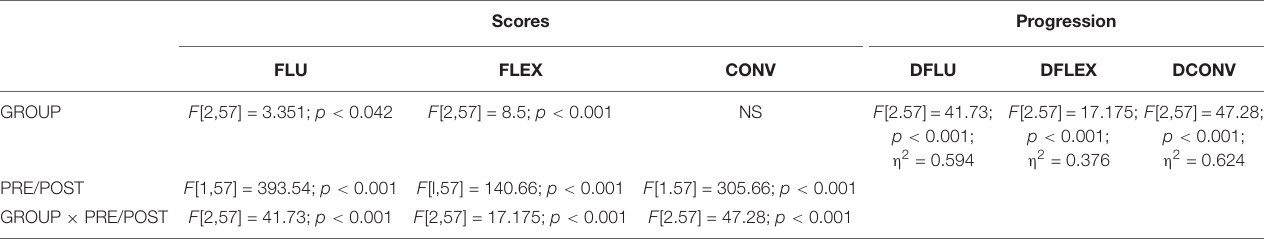
TABLE 7 | Results of the ANOVAs for FLU, FLEX, CONV and for their progressions between the PRE and POST conditions.